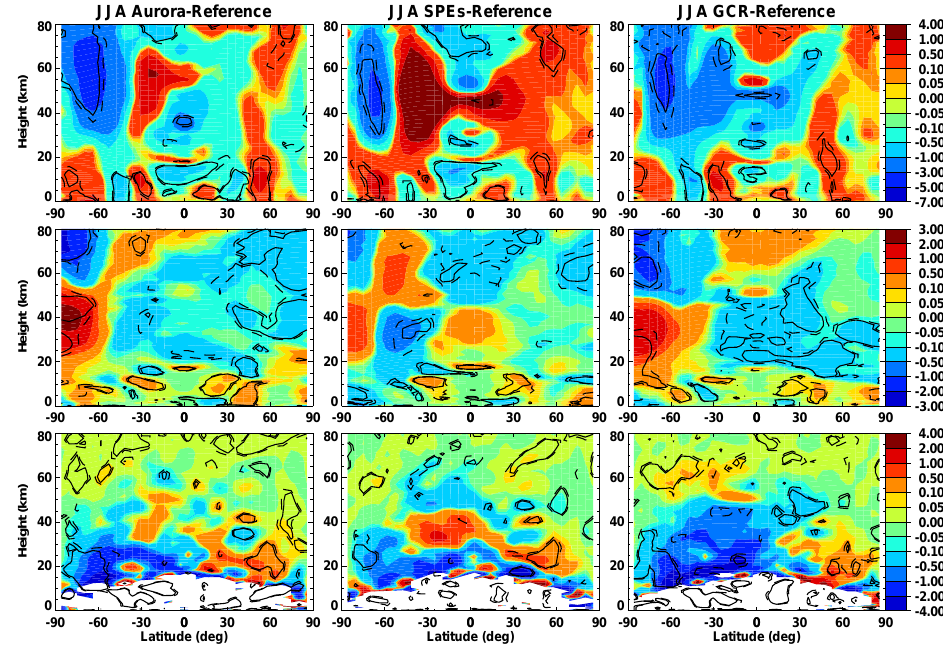
Fig. 6. Run mean, June–August mean differences compared to the reference run for auroral zone electrons (left), SPEs (center) and GCR Fig.6. Runmean, June–Augustmeandifferencescomparedtothereferencerunforauroralzoneelectrons(left), (right) showing zonal wind (top, ms − 1 ), temperature (middle, K) and mass streamfunction (bottom, kgm − 1 s − 1 , values outside the ( − 4,4) SPEs(center)andGCR(right)showingzonalwind(top, m/s), temperature(middle, K)andmassstreamfunction interval not plotted). (bottom, kg/m/s, values outside the (-4,4) interval not plotted).